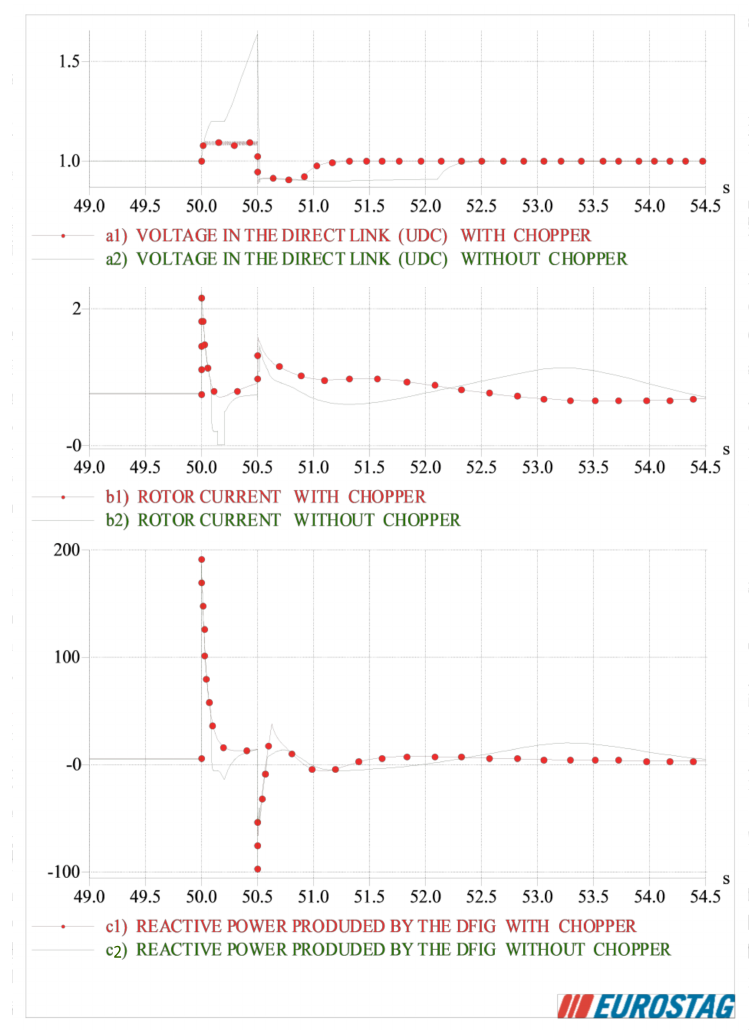
Figure 9. ( a1 , a2 ) Variation of voltage in the direct link with and without a chopper; ( b1 , b2 ) Variation of rotor current with and without a chopper; ( c1 , c2 ) Variation of reactive power produced with and without a